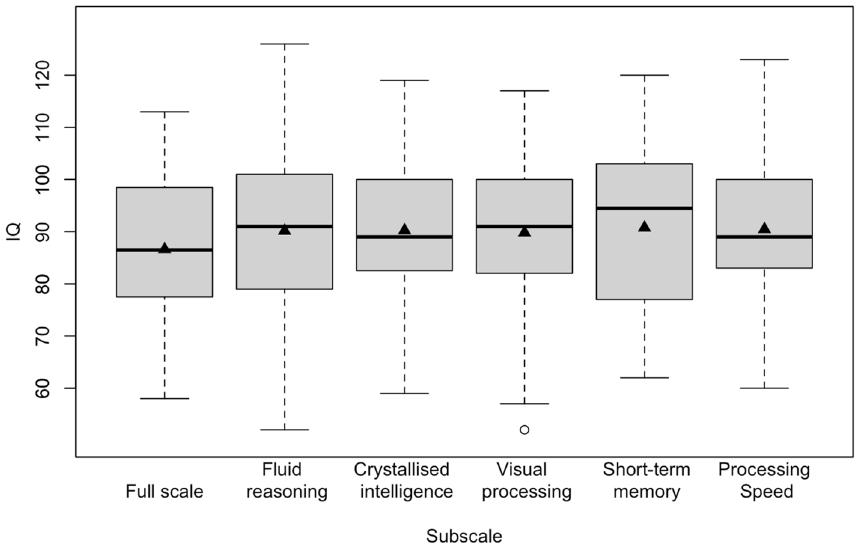
Figure 5. Subscale analysis. Results on subscale level were similar to full scale IQ and did not differ significantly (p = 0.7406). Black triangles indicate mean